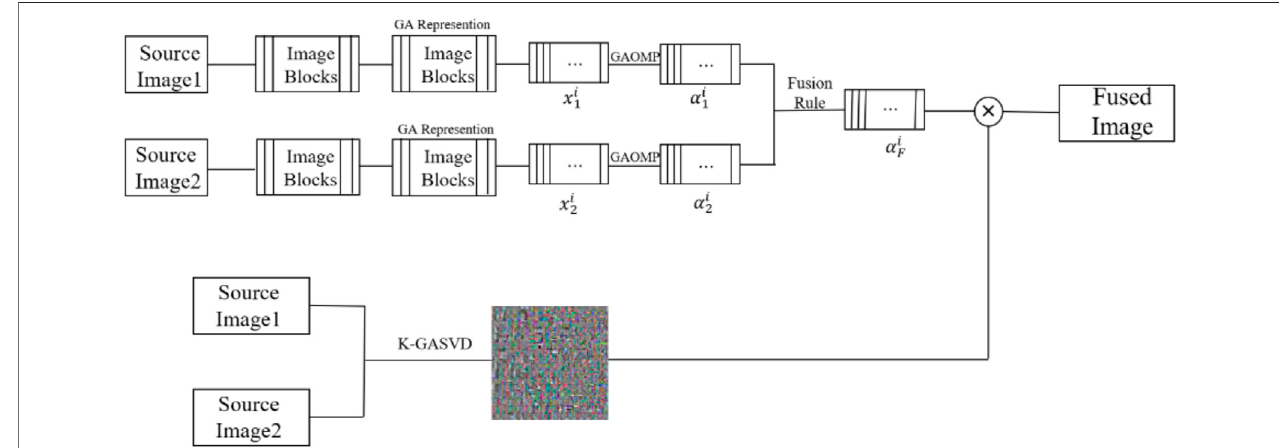
FIGURE 1 | The framework of GA-SR based multi-modal medical image fusion.